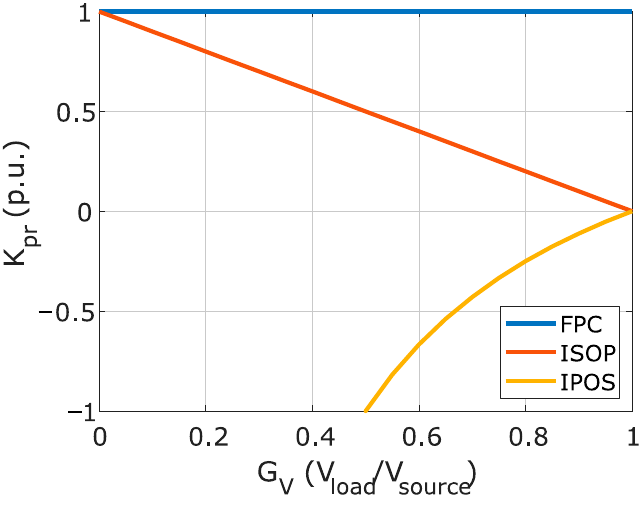
Figure 4. Processed power ratio of each converter from Figure 3.